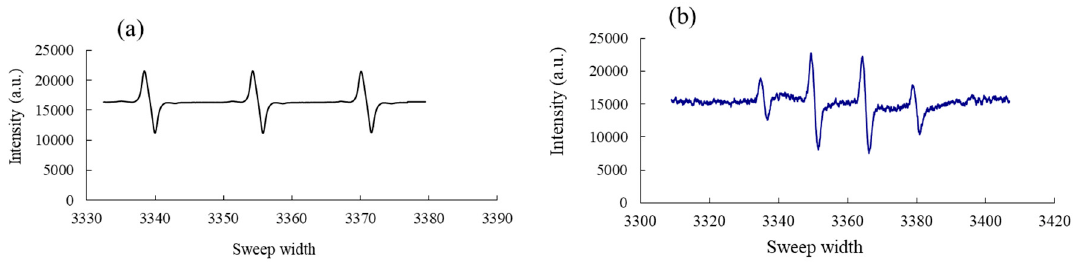
Figure 7. ESR spectra showed different patterns with different spin traps: ( a ) 1-hydroxy-2,2,6,6- tetramethyl-4-oxo-piperidine (TEMPONE-H) and ( b ) 5,5-dimethyl-1-pyrroline-N-oxide (DMPO) (present study, not published).